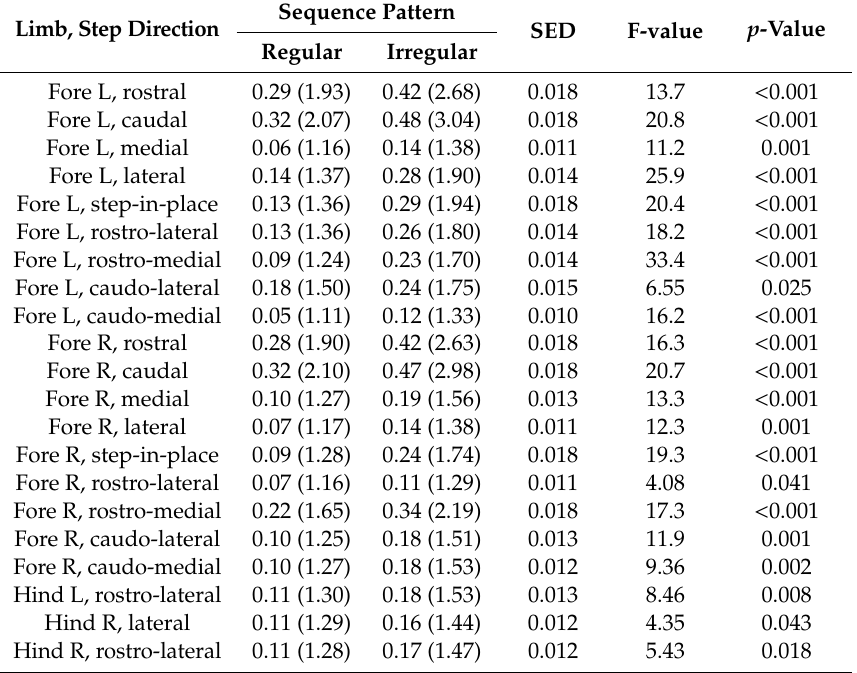
Table A2. E ff ects of regular and irregular patterned sequences of floor movement on the direction of stepping in the four limbs of sheep ( n = 6). Data presented as (log 10 + 1) steps / 20 min, with back-transformed means provided in brackets. Comparisons with significantly di ff erent counts of stepping responses are presented, as also summarized graphically in Figure 2. (L = left and R = Right. SED = standard error of the di ff erence between two means.)